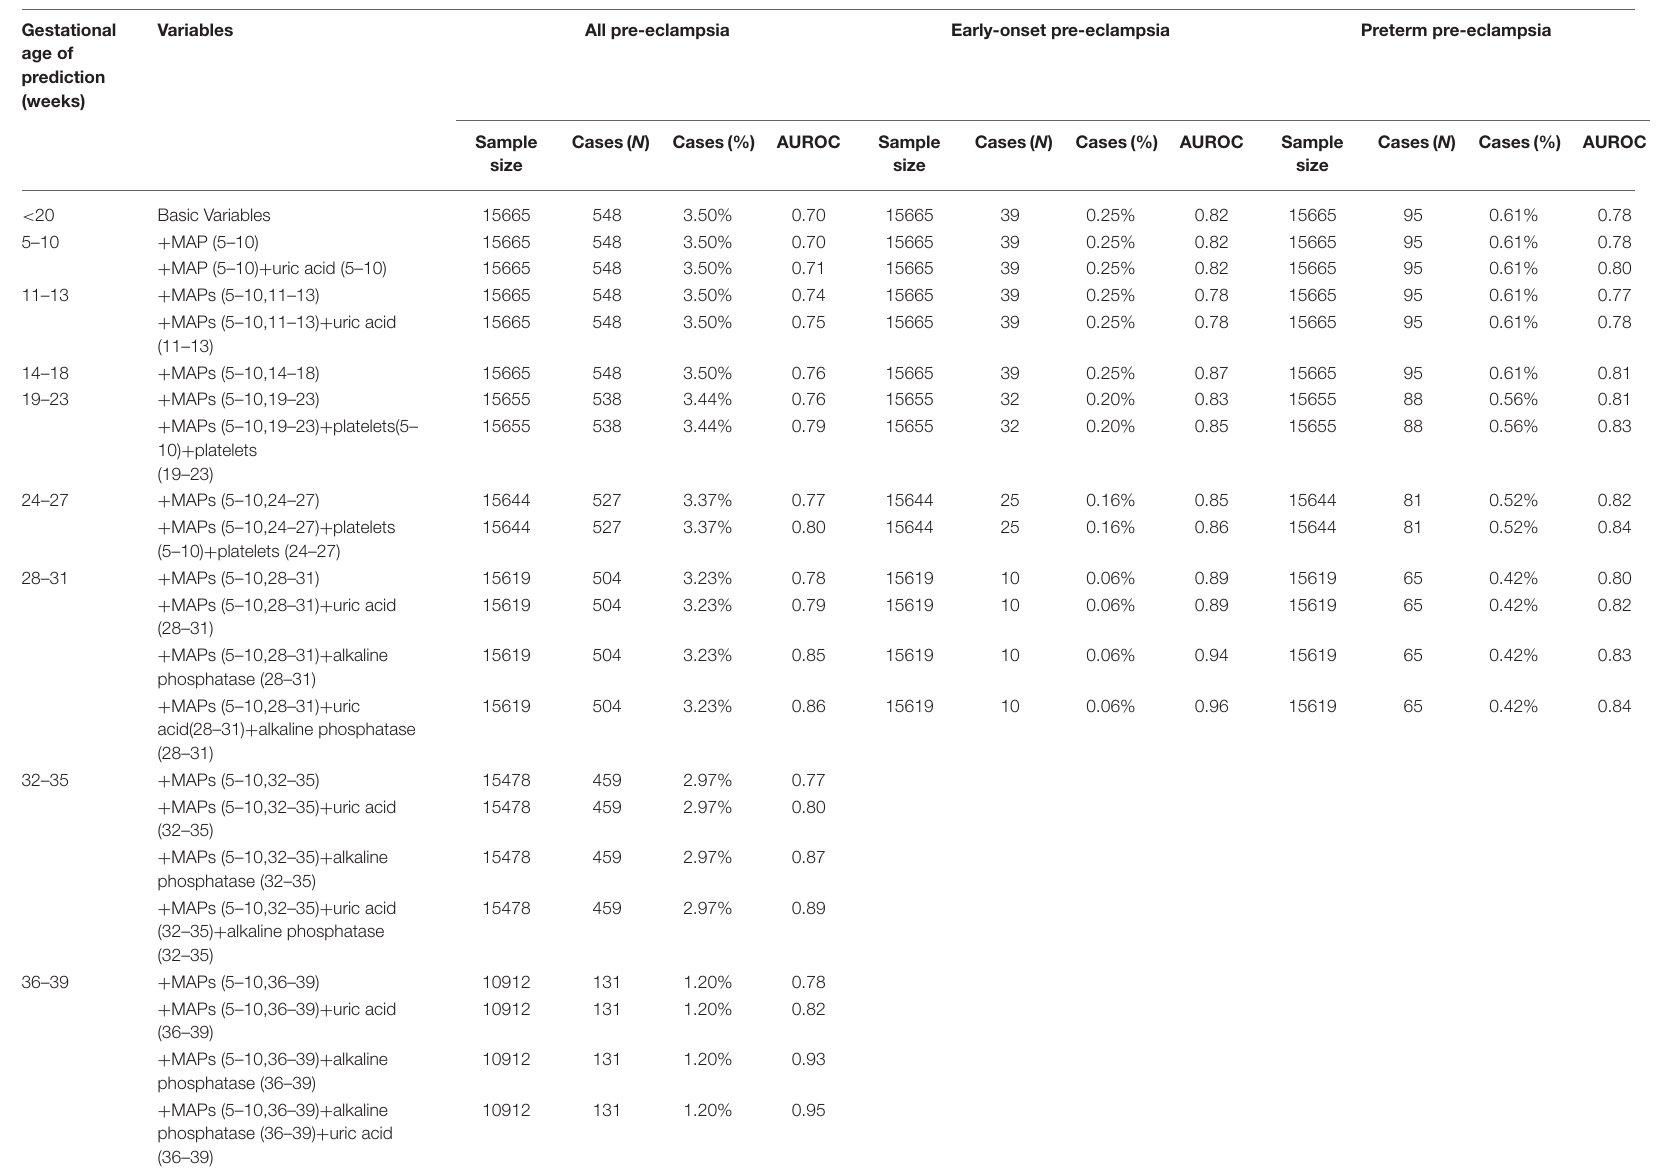
TABLE 2A | Performance of prediction model based on characteristics, medical history, mean arterial pressure, and biomarkers for all, early-onset and preterm pre-eclampsia. Gestational age